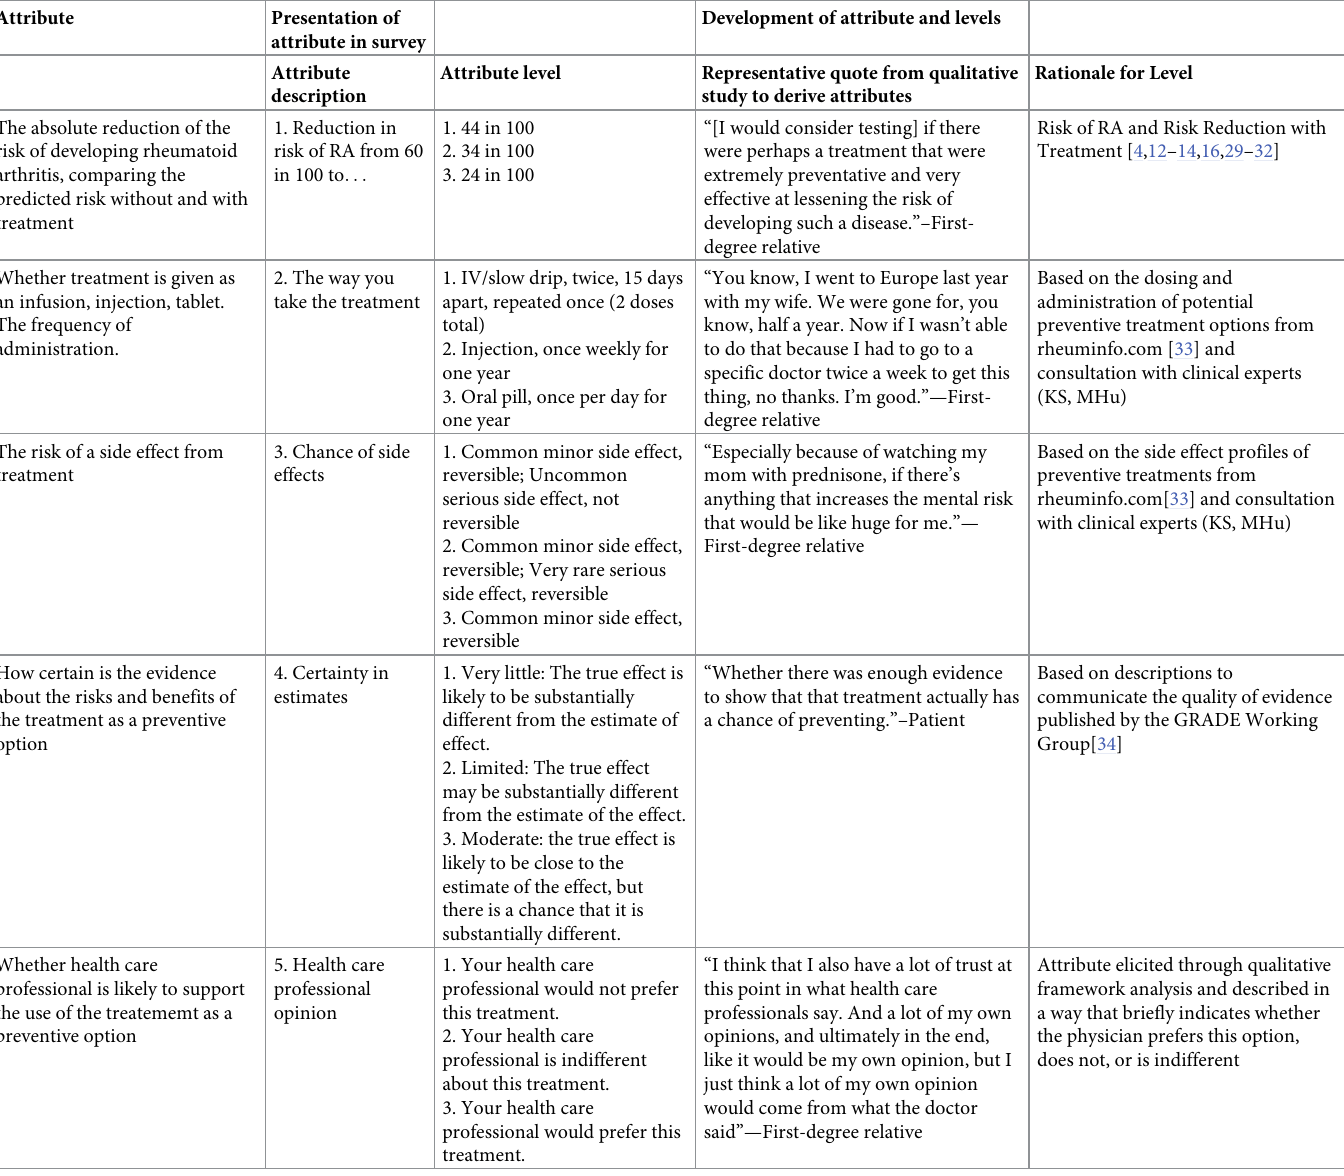
Table 1. Summary of derivation of attributes and levels within the